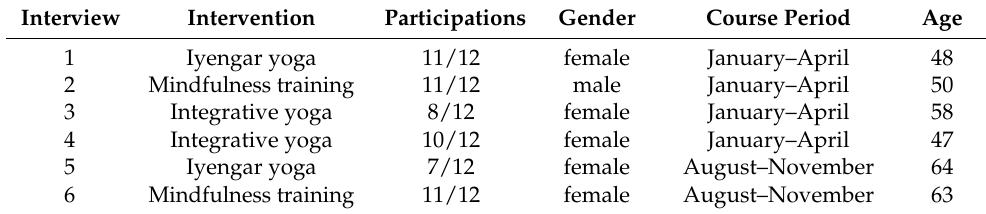
Table 4. Participant information qualitative interviews.